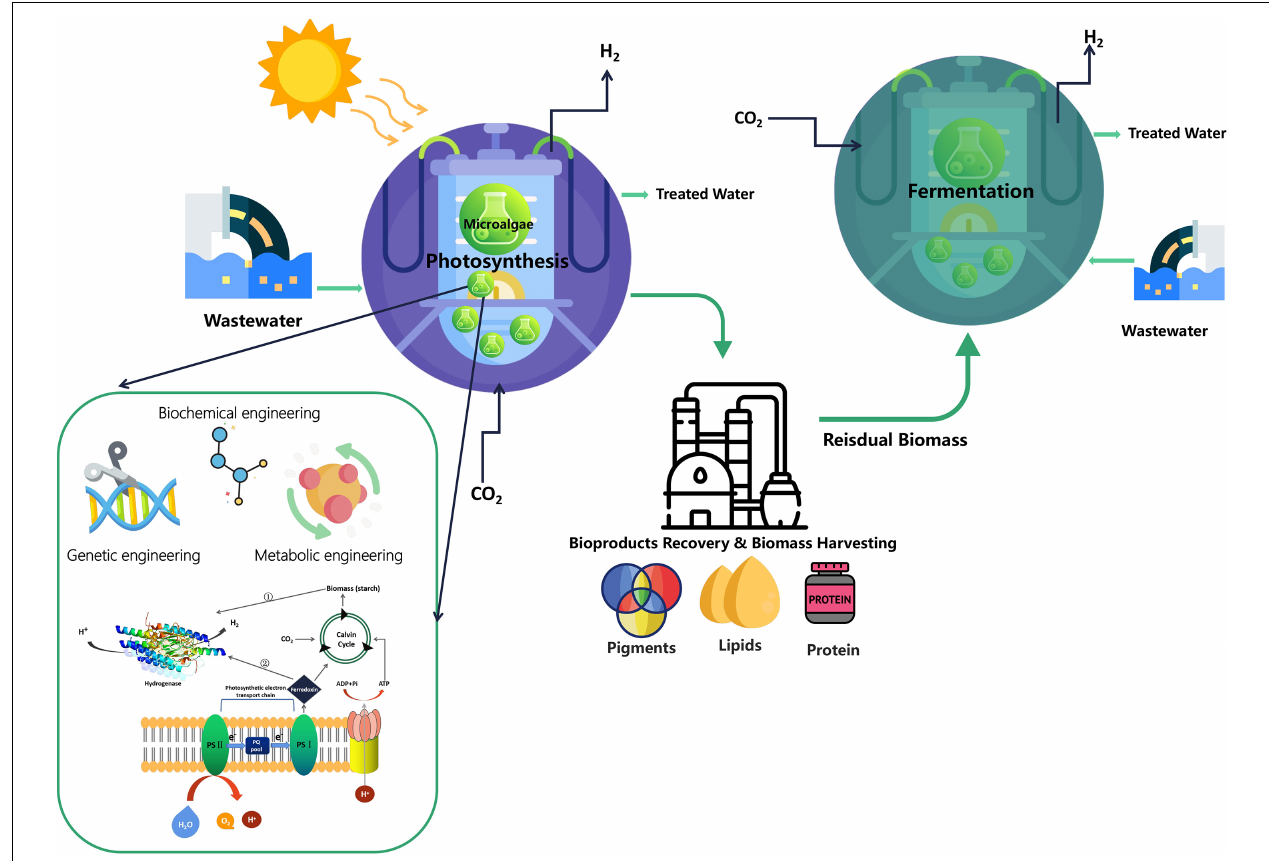
FIGURE 2 | Sustainable integrated system containing wastewater treatment for the H 2 production from